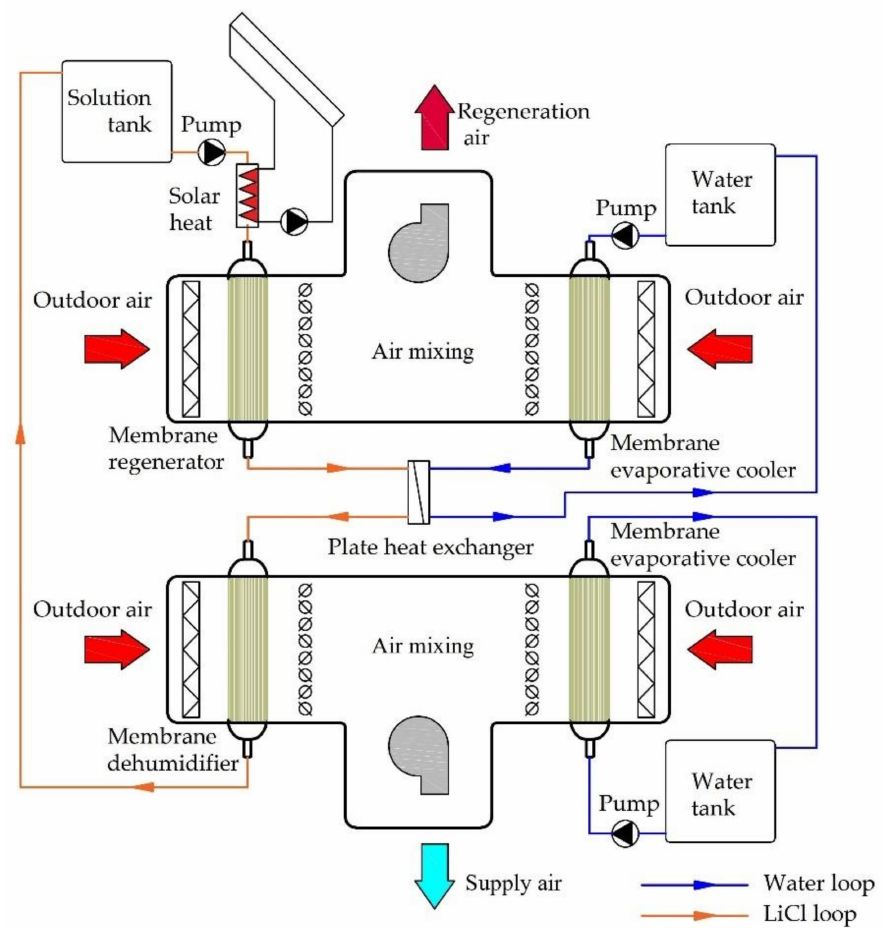
Figure 1. Membrane-based fresh air processing